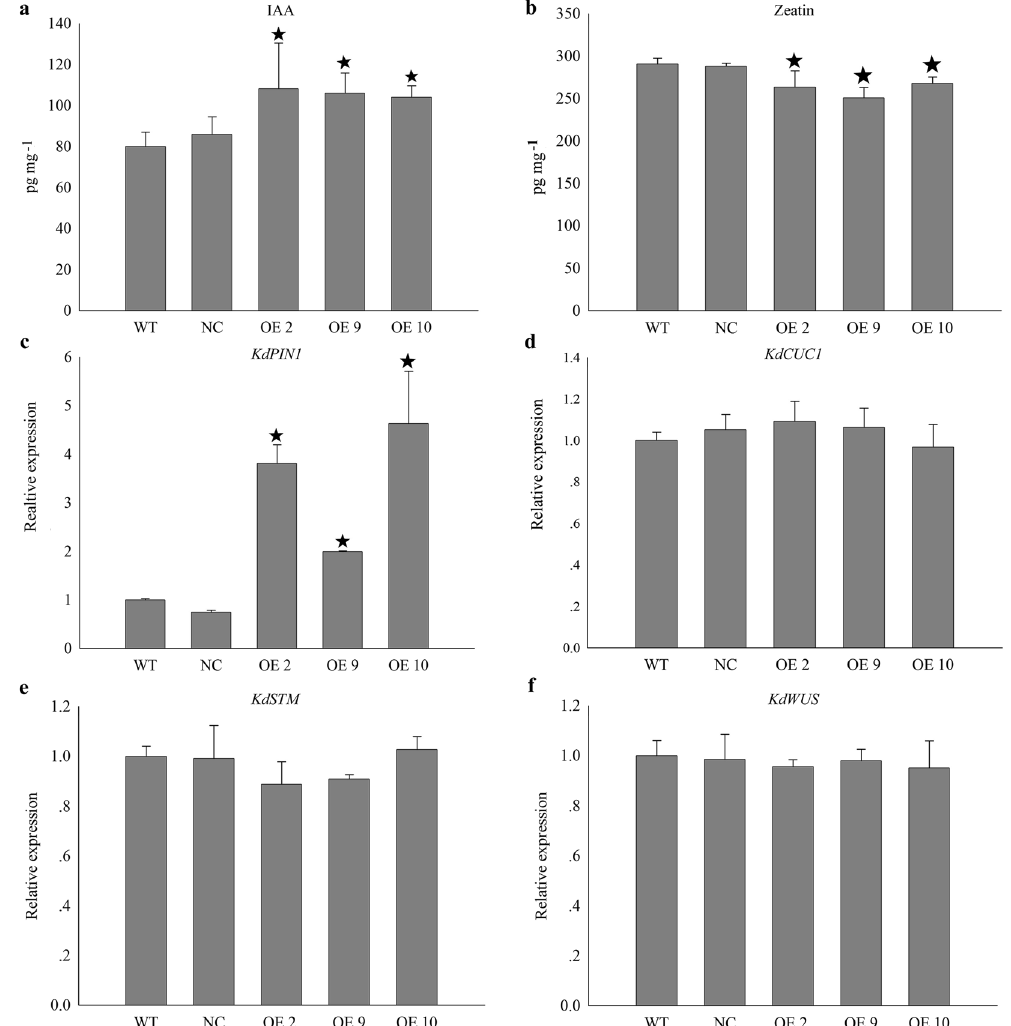
Figure 6. Hormone concentration and embryogenesis related gene expression profiles in leaves of four- month-old Kalanchoe daigremontiana OE lines. Dark pentagram indicated significantly different from the WT ( P < 0.05). Errors bars represent ± SD (standard deviations) of three independent